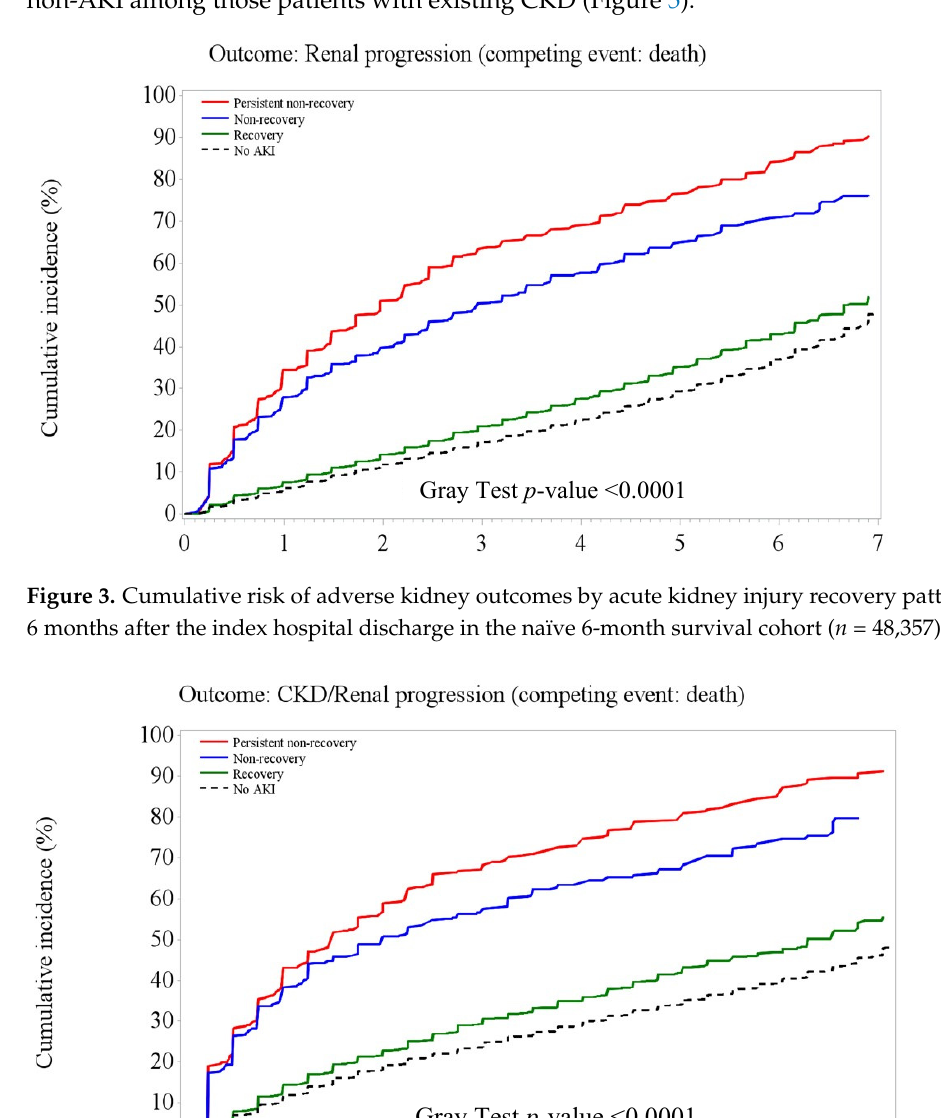
Gray Test p -value <0.0001 Figure 4. Among patients without prior chronic kidney disease (CKD, n = 32,208), the Kaplan–Meier plot shows that the highest risk of composite adverse kidney outcomes (including CKD onset) was in the PNR- and NR-AKI groups, and the risk was lower in the recovery AKI and no-AKI group.